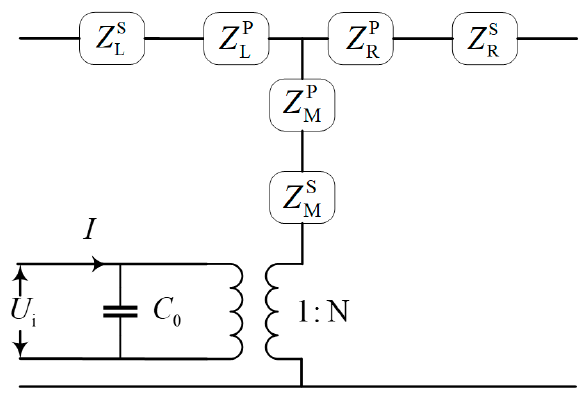
Figure 2. The equivalent circuit of the piezoelectric stack and screw bolt.